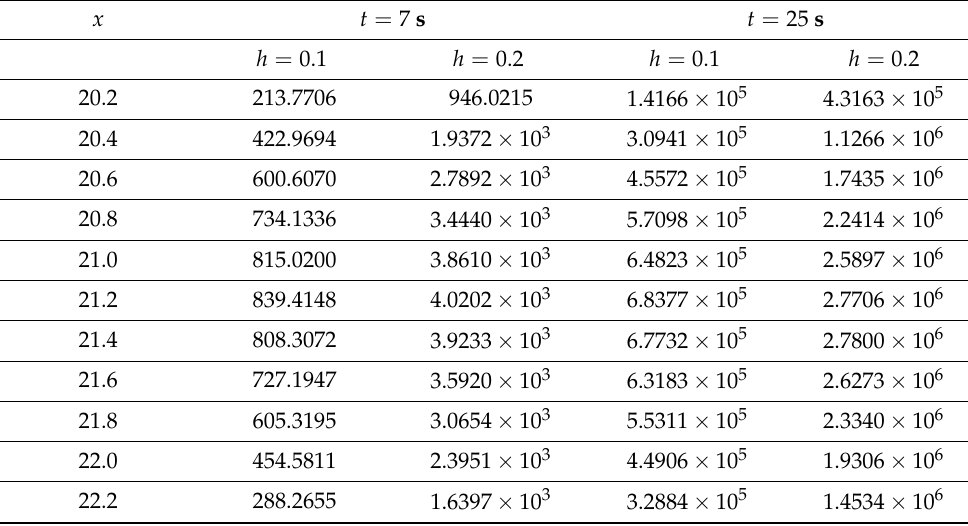
Figure 6. WSE ( η ) of SWWE for h = 0.1 and h = 0.2 at t = 25 s. Table 3. Amplitude of the shallow water wave .